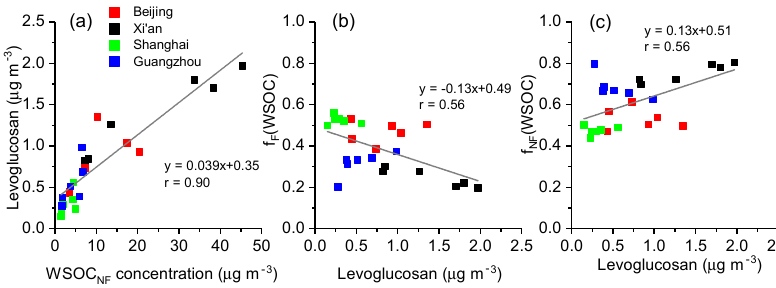
Figure 4. Relationships of non-fossil derived WSOC (WSOC NF ) and levoglucosan (a) , levoglucosan and the fraction of fossil in WSOC ( f F (WSOC)) (b) and levoglucosan and the fraction of non-fossil in WSOC ( f NF (WSOC)) (c)